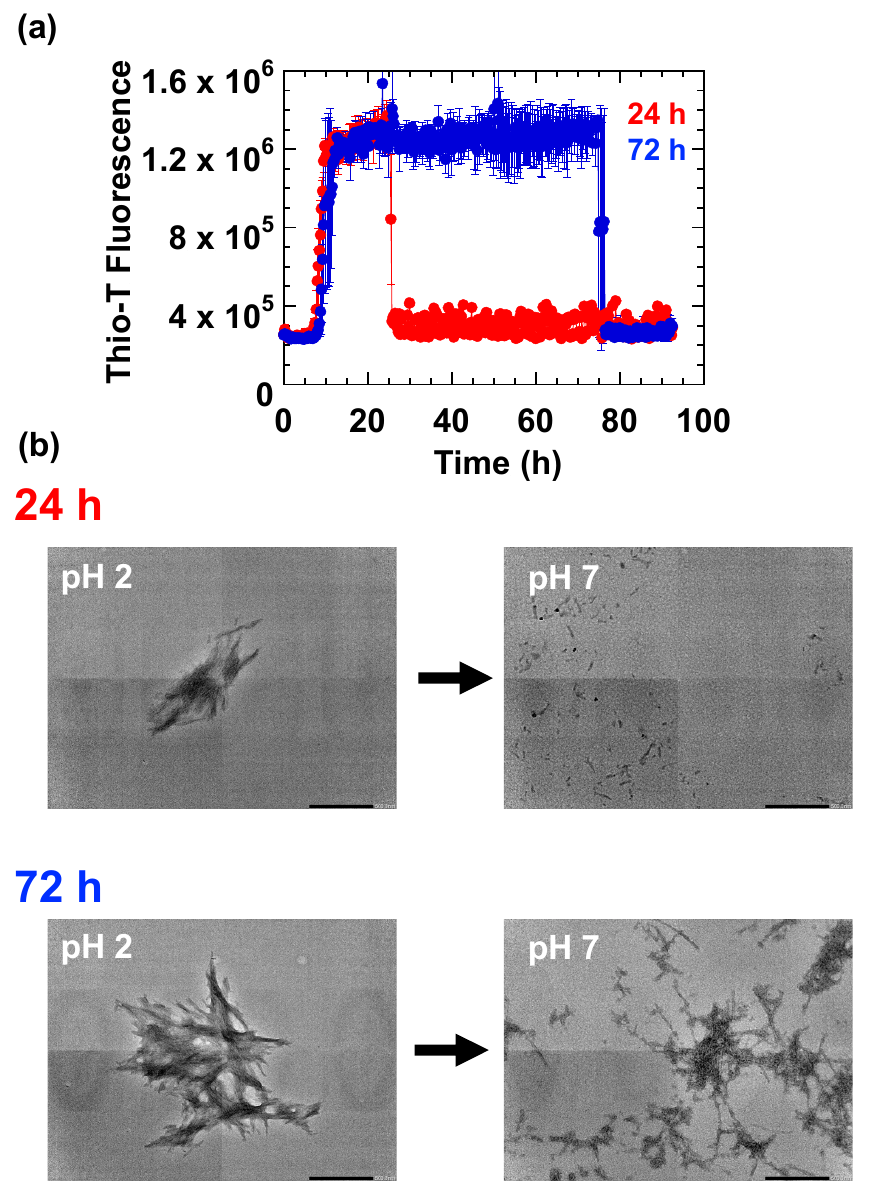
Figure 3. Extended incubation of HdeB fibrils at pH 2 leads to the appearance of a fibril form that can not be resolubilized at pH 7. ( a ) Time course of Thio-T fluorescence change. Two sets of experiments were performed in parallel. In the first set, samples of HdeB were incubated at pH 2.0, 250 mM NaCl to induce the formation of fibrils and subsequently shifted to pH 7.0 after 24 h. In the second set, HdeB was allowed to form fibrils at pH 2.0 as in the first set, but the samples were incubated (with shaking) for a further 48 h before adding Tris base to shift the pH to 7.0. For each set, representative aliquots were sampled before and after addition of Tris base to induce pH shift, and TEM images from these samples are shown in ( b ). Images were obtained at a magnification of × 20,000 (scale bar; 500 nm). Traces are averages ± standard errors of four separate samples obtained in two separate experimental